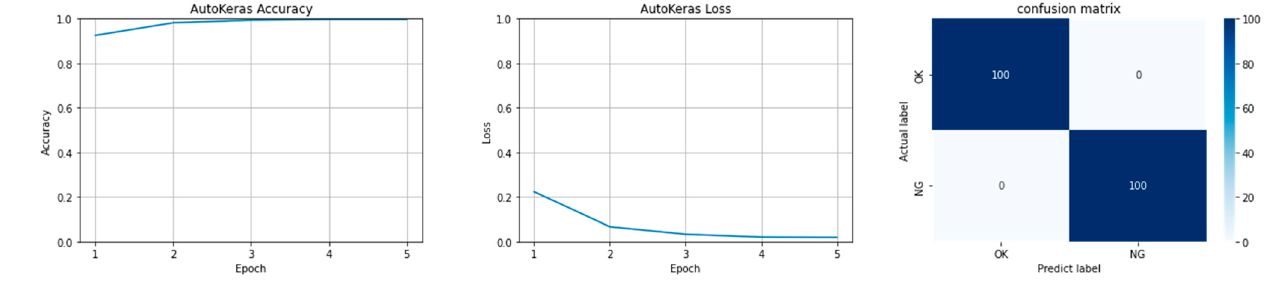
Figure 15. Accuracy, loss, and confusion matrix for AutoKeras